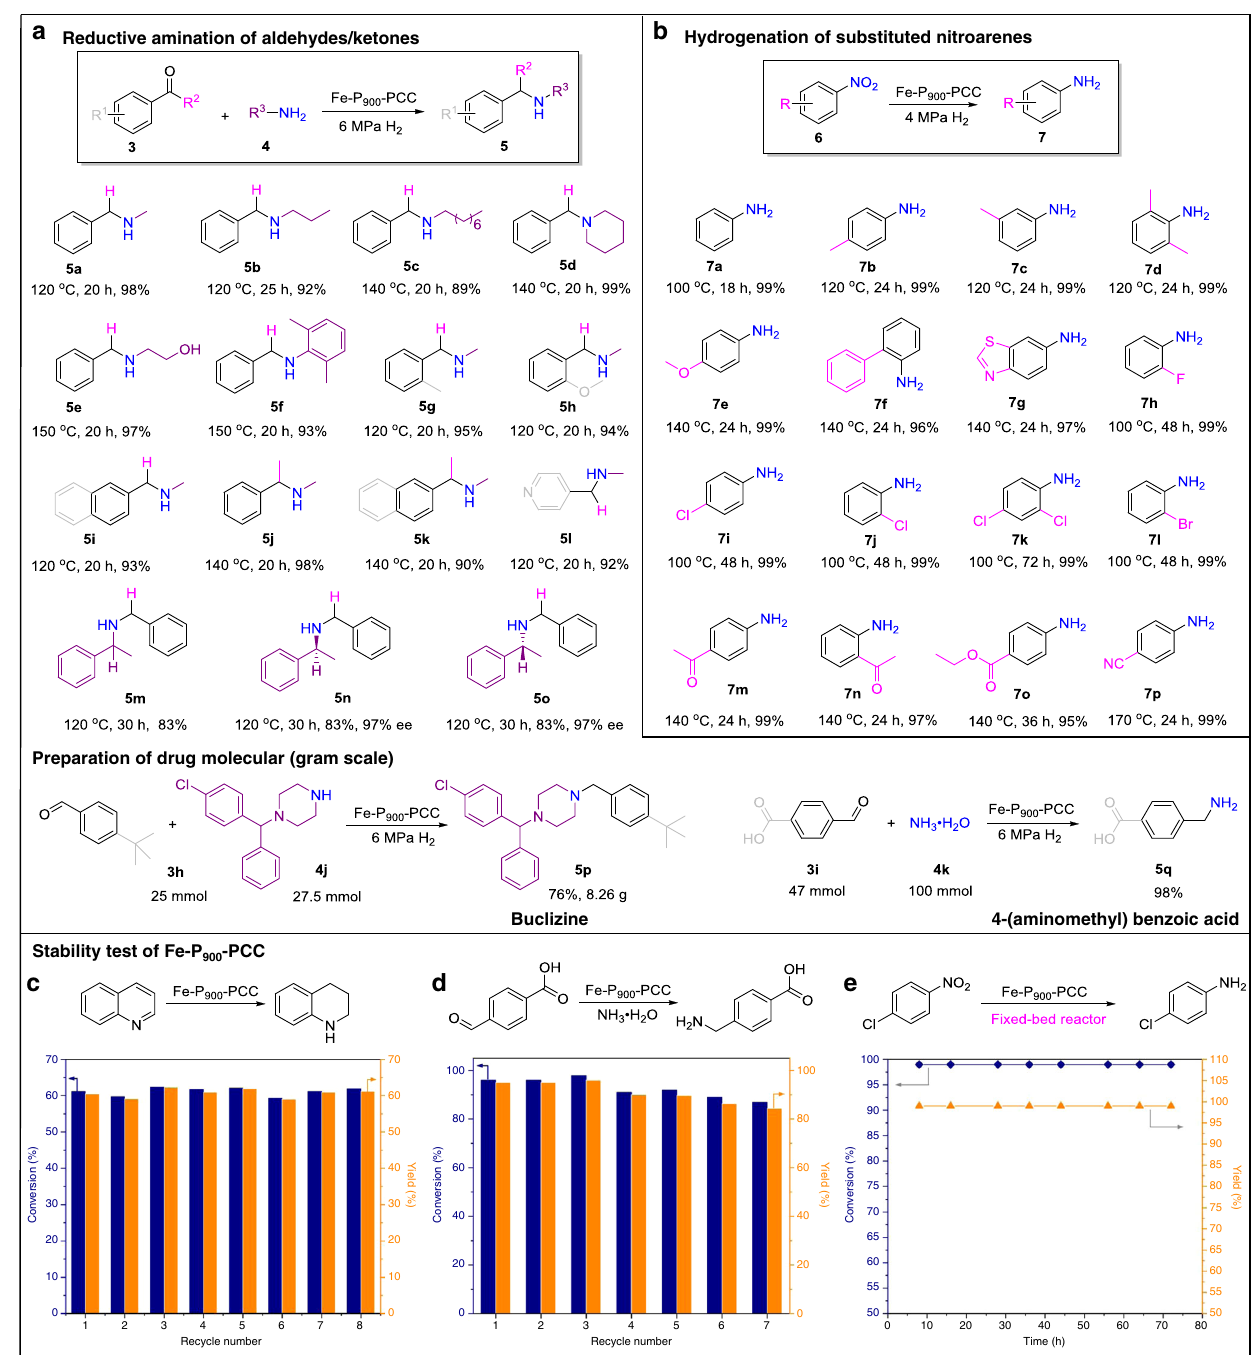
Fig. 5 Fe-P 900 -PCC catalyzed reductive amination and hydrogenation reactions. a Reaction conditions: 2 mmol aldehydes/ketone, 40 mg Fe-P 900 -PCC, 3 mmol amine, 5 mL ethanol, 6 MPa H 2 . Yields are determined by GC using 1,4-dioxane as an internal standard. Reaction conditions of gram scale experiments: for synthesis of 5p , 25 mmol 3h , 27.5 mmol 4j , 500 mg Fe-P 900 -PCC, 30 mL ethanol, 6 MPa H 2 , 120 °C, 30 h, isolated yield; for synthesis